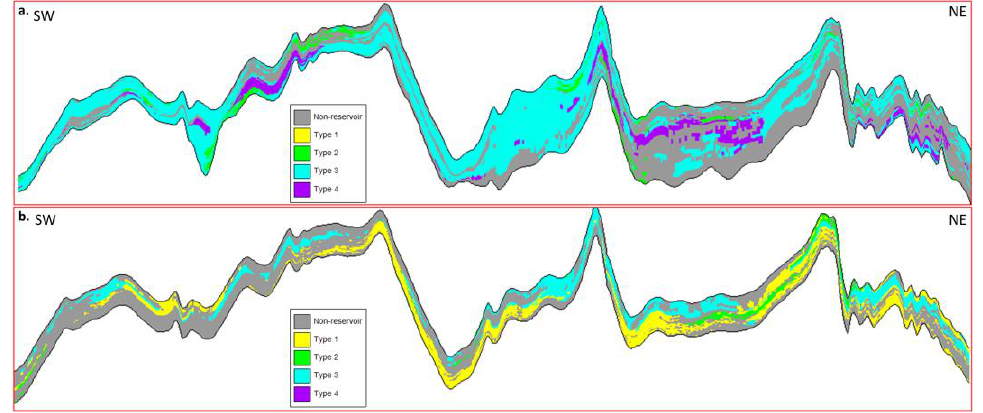
Figure 19. SW – NE intersections of rock type model of Unit 4 ( a ) and Unit 5 ( b ). The rock type shows inverse variation trends in Unit 4 and Unit 5. Rock type 1, which has the best reservoir quality, only exists in the conventional gas reservoir in Unit 5.